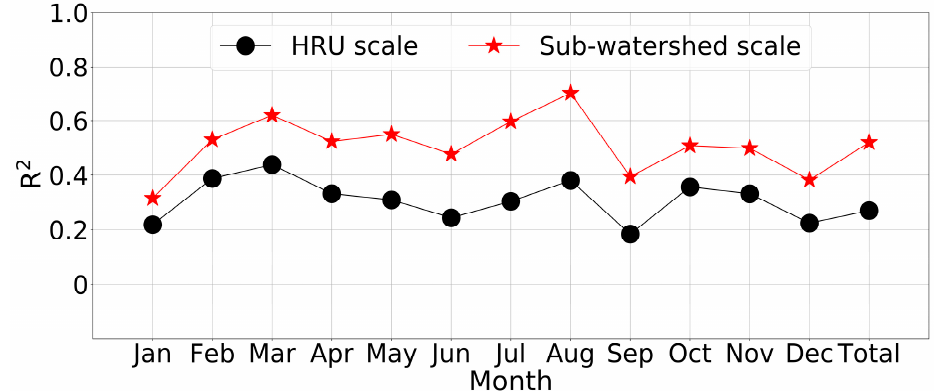
Figure 9. The R 2 of the MLR formulation for different months at HRUs and sub-watershed